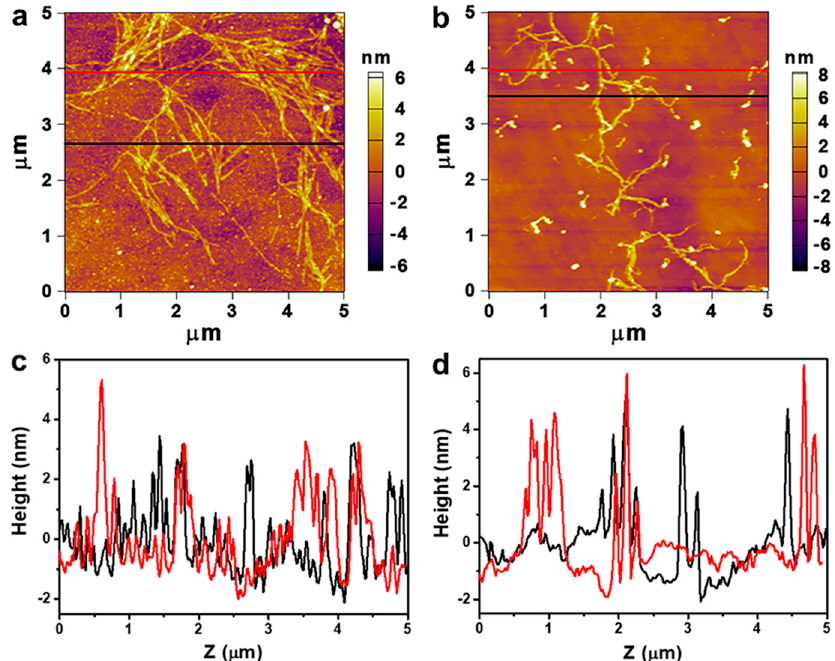
Figure 7. Atomic force microscopy (AFM) images of CC in ( a ) 7 wt% NaOH and ( b ) 7 wt% NaOH/1.6 wt% ZnO aqueous solutions (c = 1.0 × 10 − 4 g/mL). ( c , d ) the height distributions of CC as indicated by the red and black lines in ( a , b ).